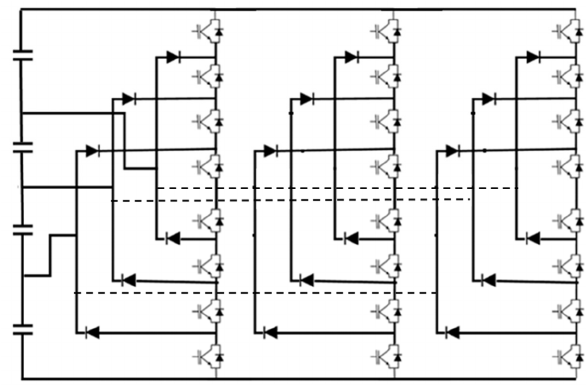
Figure 1. Five-level diode clamped voltage source inverter.